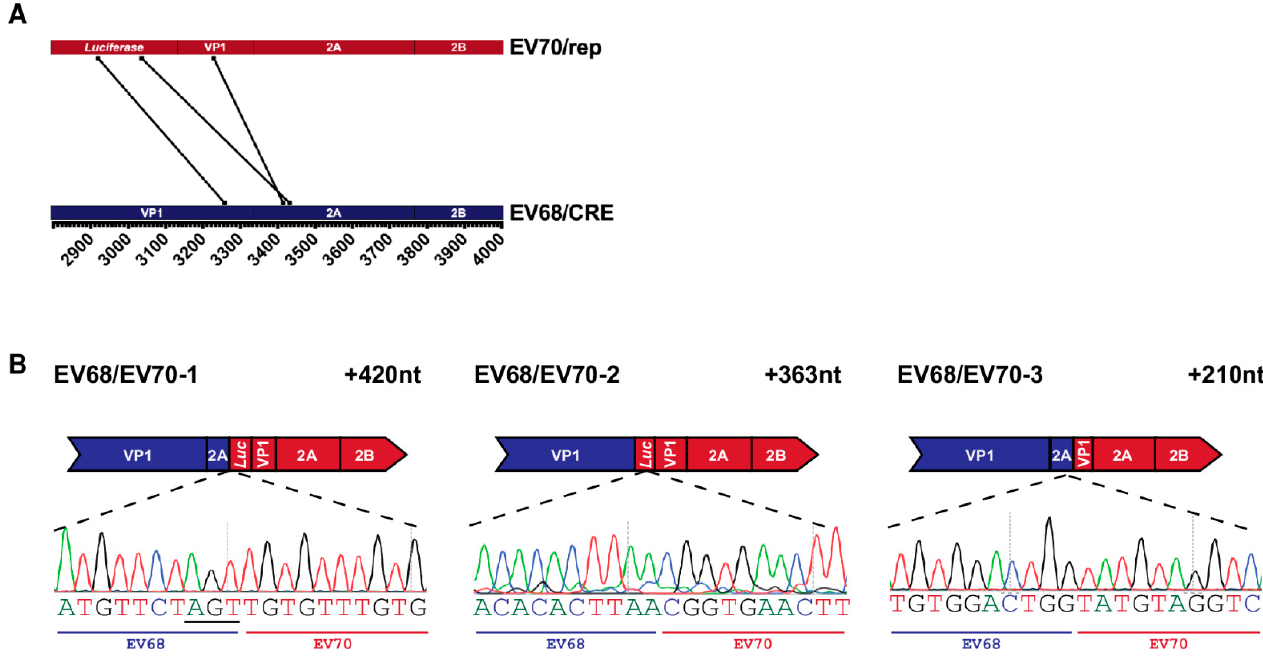
Figure 4. Recombinant genomes isolated from EV68/EV70 CRE-REP assay: ( A ) parallel coordinates visualisation of EV68/EV70 recombinant genomes. The location of each recombination junction was mapped respectively to each parental genome. Each line represents a unique recombinant; ( B ) schematic representation of each identified recombinant. Recom- binant name is given top left and the size of each sequence duplication is top right. The relevant part of the recombinant sequence chromatogram is shown below, with the acceptor and donor-derived regions indicated based on the determined junction position. Nucleotides underlined in recombinant sequence represent regions of ambiguity where both parental sequences match. Although labelled as acceptor, it cannot be determined from which template these particular nucleotides were derived. Table 2. Recombinant genomes.